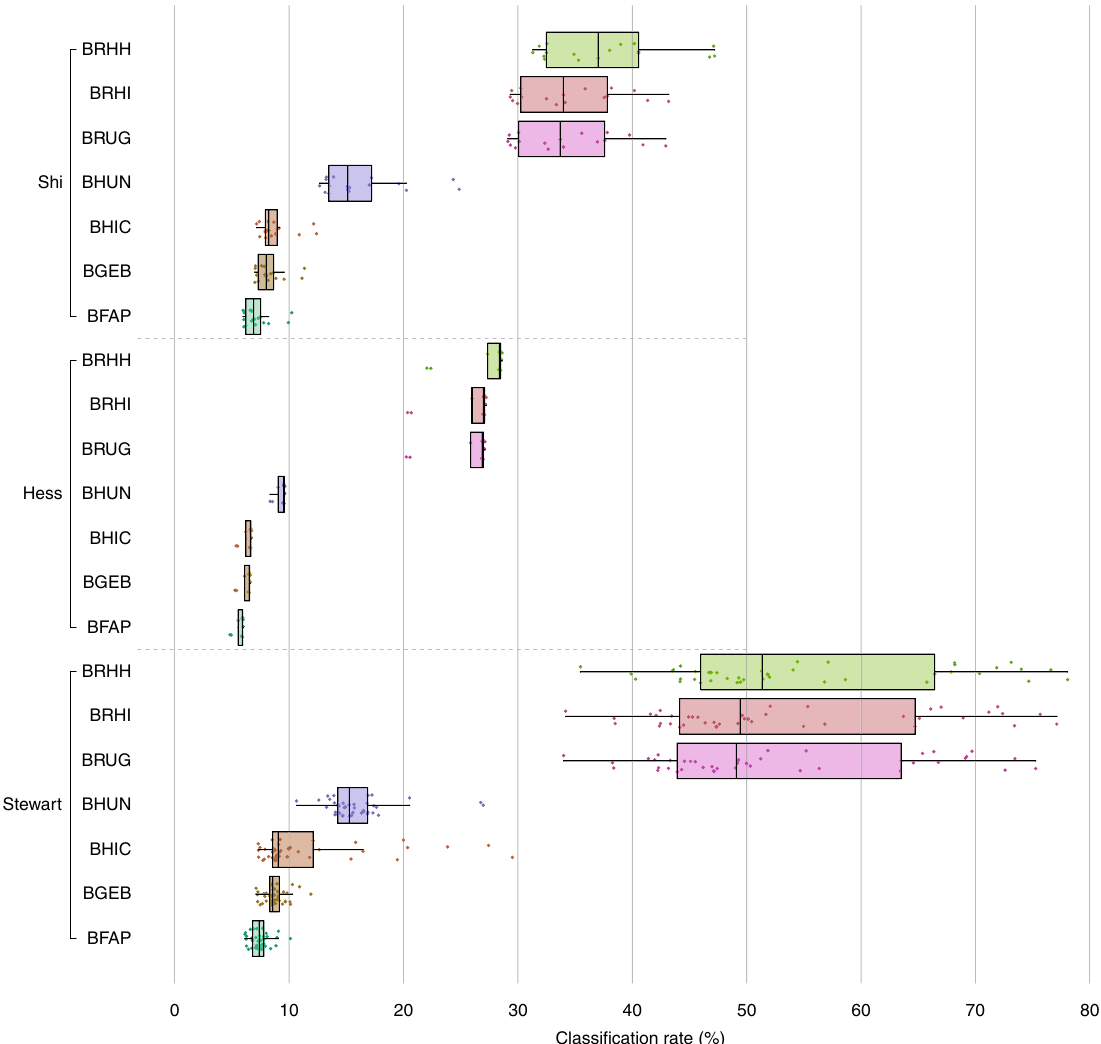
Fig. 4 Classi fi cation rate for three datasets against various Kraken databases. BFAP bacterial, archaeal, fungal and protozoan genomes from RefSeq, BGEB BFAP + 1003 GEBA genomes, BHIC BFAP + 63 hRUG genomes, BHUN BFAP + 410 genomes from the Hungate 1000 project, BRUG BFAP + 850 RUG MAGs, BRHI BFAP + all 913 genomes from this study, BRHH BFAP + 913 RUGs + 410 Hungate 1000 genomes. Addition of rumen-speci fi c RUGs or Hungate 1000 genomes has the most dramatic